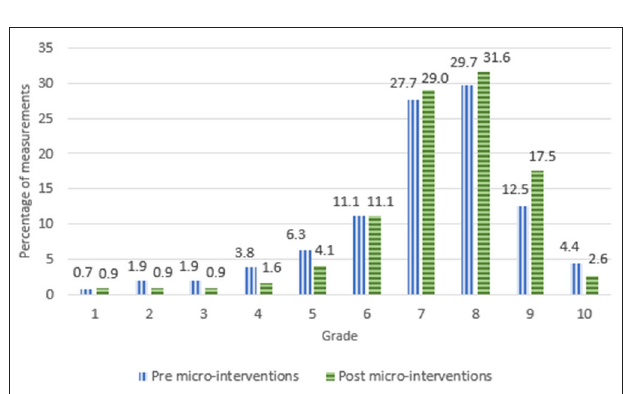
FIGURE 7 | Grades given to the soundscape pre- and post-implementation of micro-interventions.